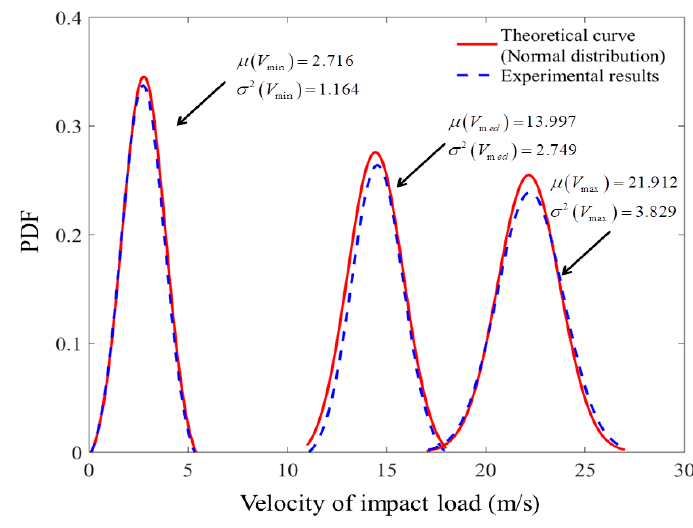
Figure 14. Comparison of PDF results of random wind velocity.